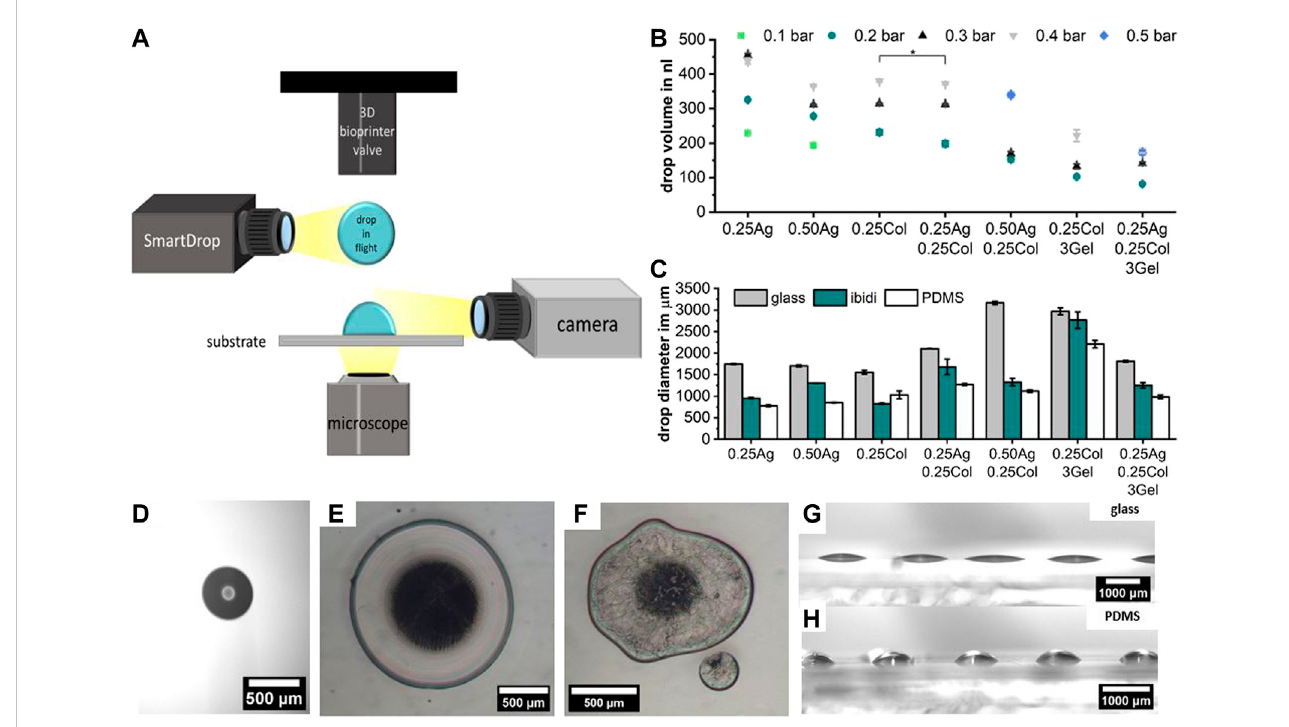
FIGURE 4 Schematic representation of the optical characterization of hydrogel blend printability, including the drop volume in fl ight using an embedded “ SmartDrop ” system, the effective drop diameter after printing on various substrates using an optical microscope, and the wetting behavior observed by camera (A) .Thedropvolumefordifferentprintpressuresmeasuredusingthe “ SmartDrop ” system;with p < 0.001unlessstatedotherwise,numberofsamples for each data point is in Supplementary Figure S2 (B) . The drop diameter on three different substrates measured using an optical microscope is given for the minimum printable pressure in bar noted on top of the bars (C) . Example image of the drop volume detection in fl ight (D) . Microscopy of drops of 0.25Ag (E) andof0.25Ag0.25Col3Gel (F) printedonPDMS at0.2 barclearlyshowthedifferenceinroundnessand theoccurrenceofsatellite drops forAgCol-blends. The difference in effective drop area for different substrates is caused by the wetting behavior, as shown for 0.50Ag on glass (G) and PDMS (H) printed with 0.2 bar print pressure; n =